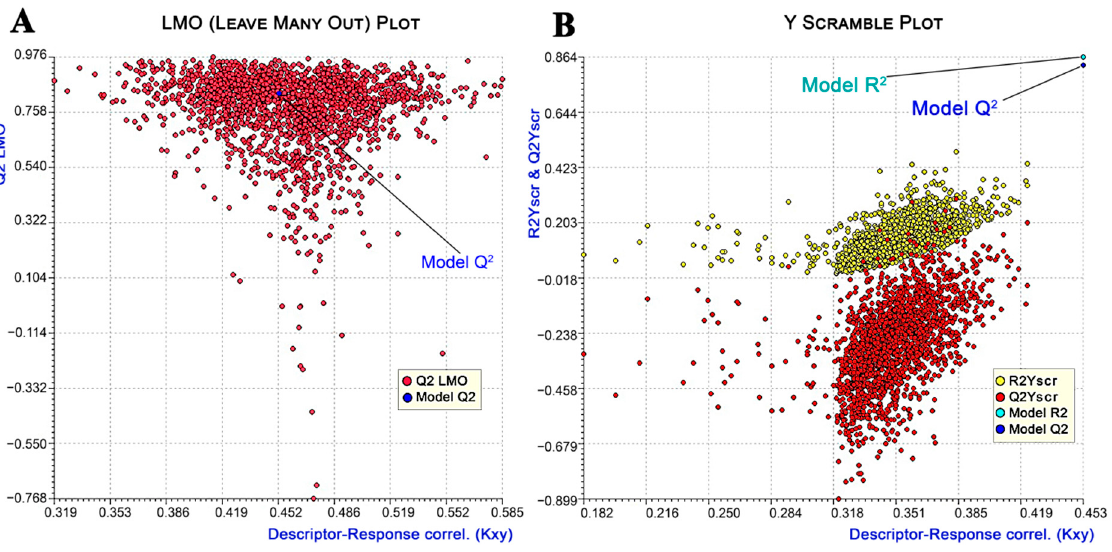
Figure 3. Leave ‐ many ‐ out (LMO) plot ( A ) and Y ‐ randomization plot ( B ) of 2000 iterations for in ‐ Figure 3. Leave-many-out (LMO) plot ( A ) and Y-randomization plot ( B ) of 2000 iterations for internal ternal validation of the developed model. validation of the developed